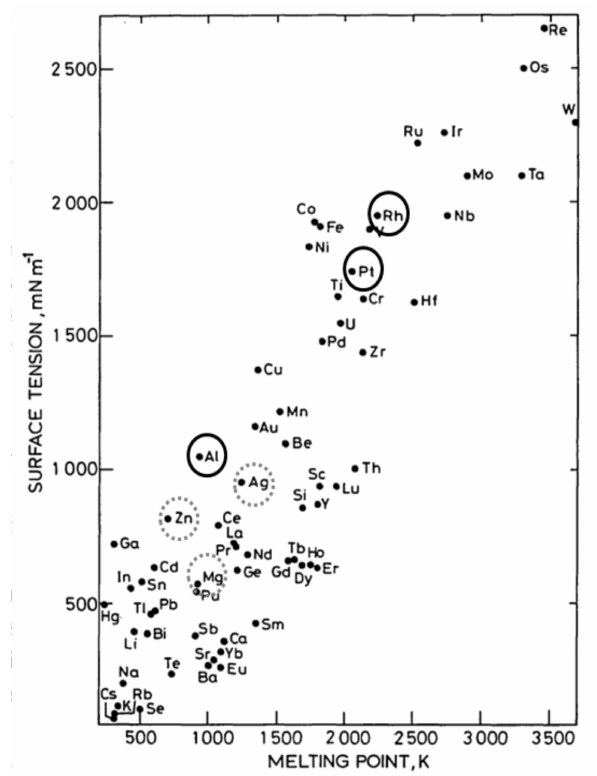
Figure 6. Surface tension of molten metals depending on their melting temperature